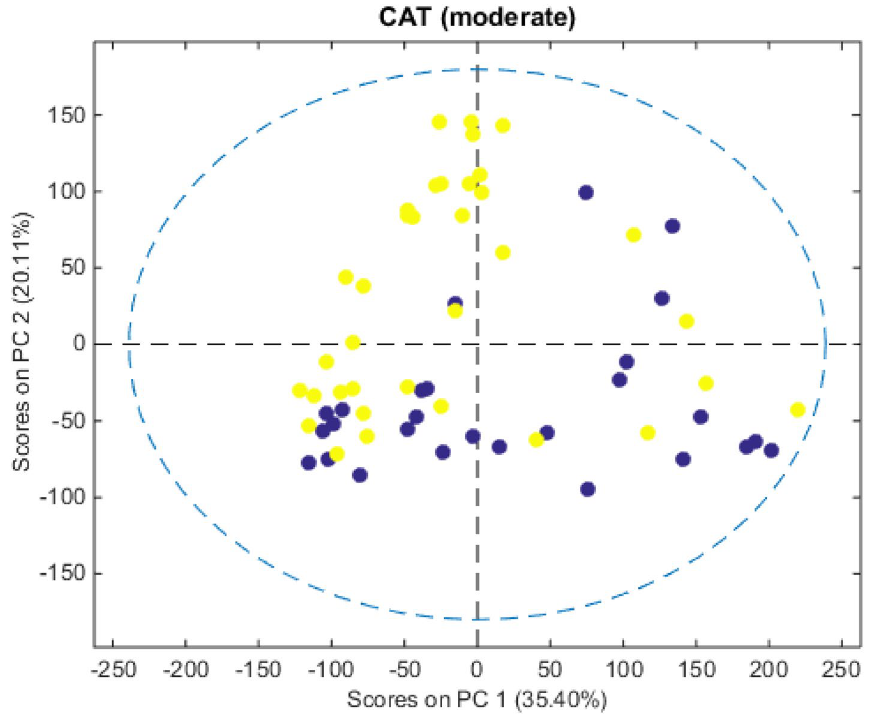
Figure 2. Graphs of PC1 versus PC2 scores for the moderate CAT symptom, with CG (yellow) and FG (blue) samples and confidence ellipses (dashed circles) for the analyzed datasets. The percentage of total variance for each PC is described in parentheses. Graphs of the other symptoms can be found in the supplementary information (Fig.